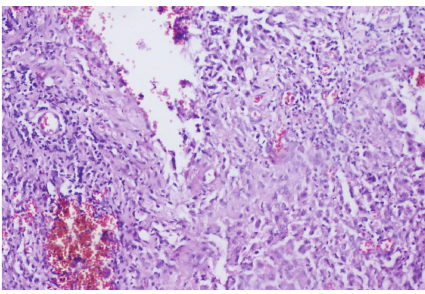
Figure 4: HPE photograph ( × 100 magnification) showing wall of abscess with granulation tissue and inflammatory infiltrate.